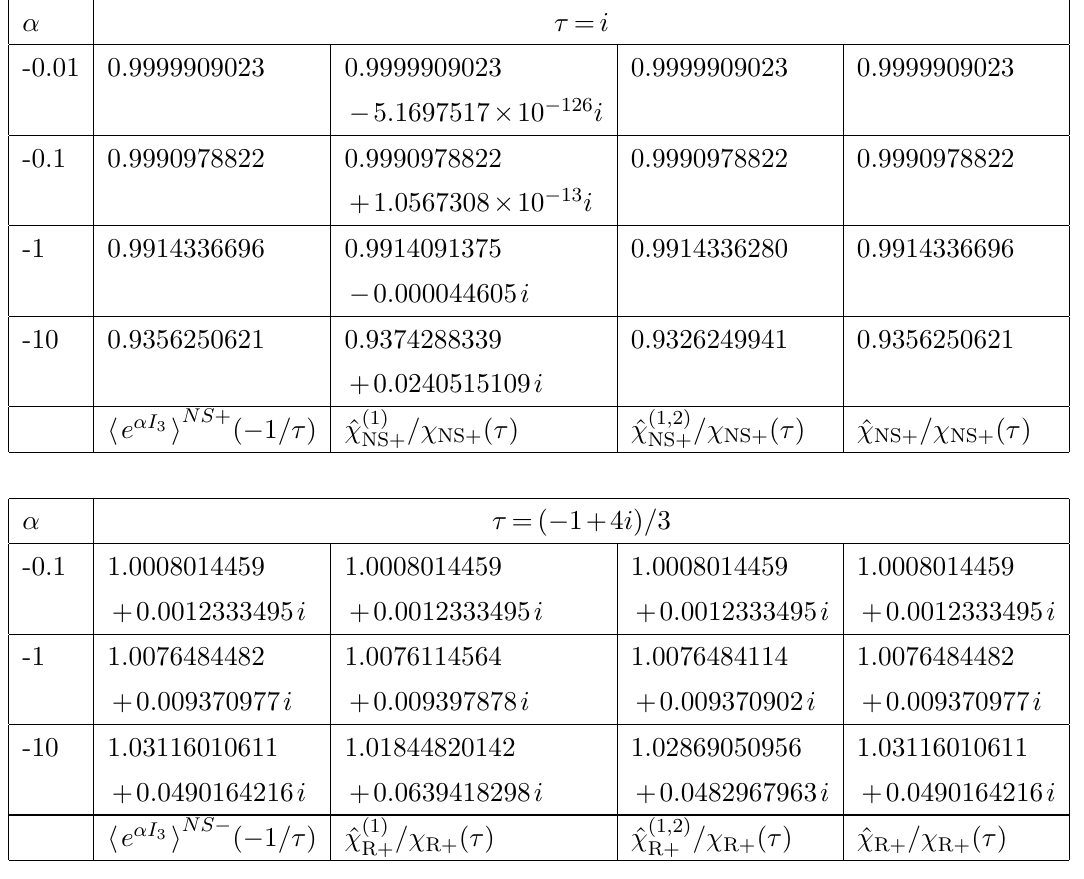
Table 1. Table of values of a GGE including a coupling to a single charge I sectors calculated using the exact result from the expression of the charge as a fermion bilinear in one channel and the asymptotic expression, an improved asymptotic expression and a conjectured exact answer in the opposite